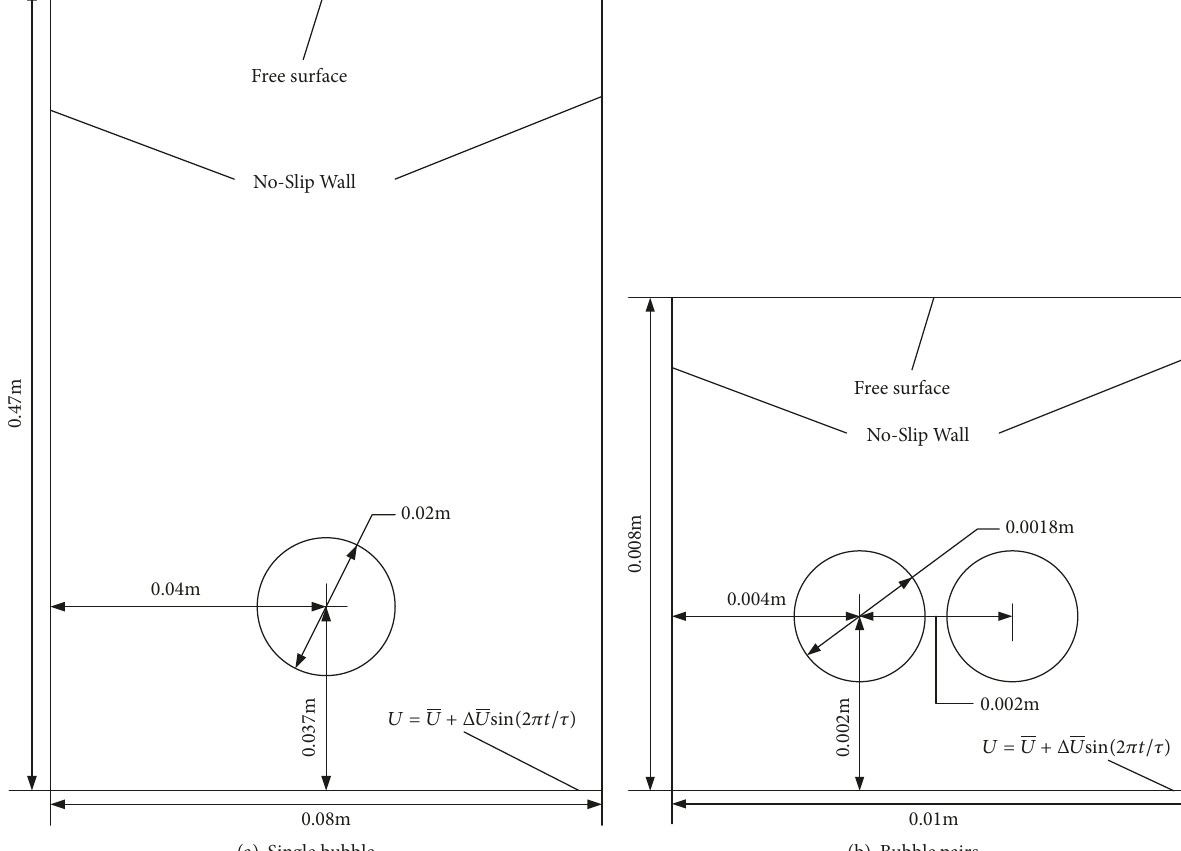
Figure 1: Initial geometry and boundary arrangement under flow pulsation